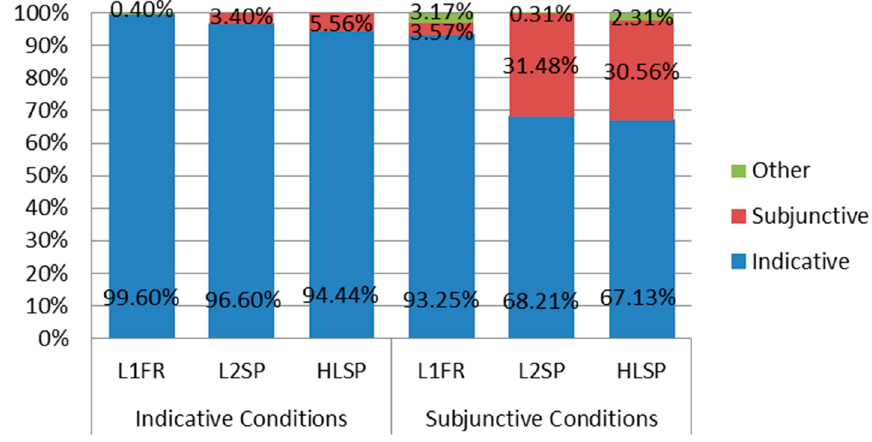
Figure 6. Overall results, broken down by condition. Task 2—Elicited production task.